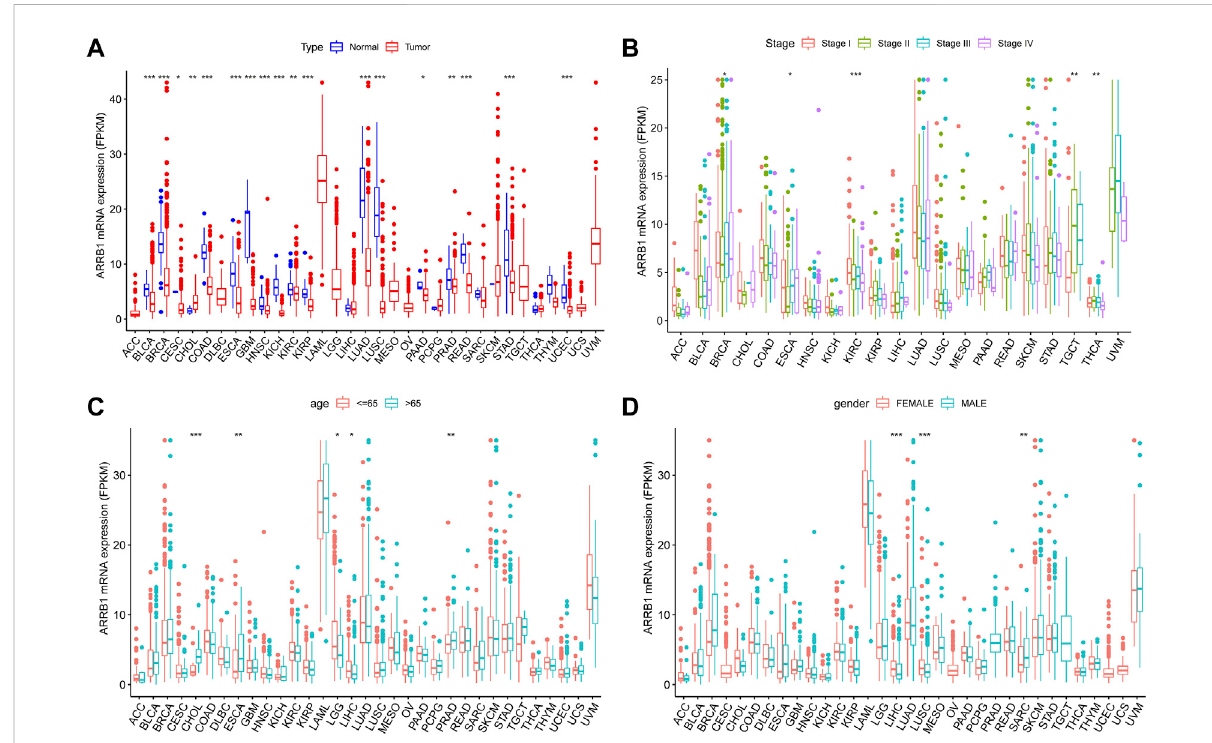
FIGURE 1 The clinical correlation of ARRB1. (A) The differential expression of ARRB1 mRNA between the tumor and normal groups in 33 cancer types. (B) ARRB1 mRNA expression levels in tumors of different stages. (C) ARRB1 mRNA expression levels in different age groups. (D) The correlation